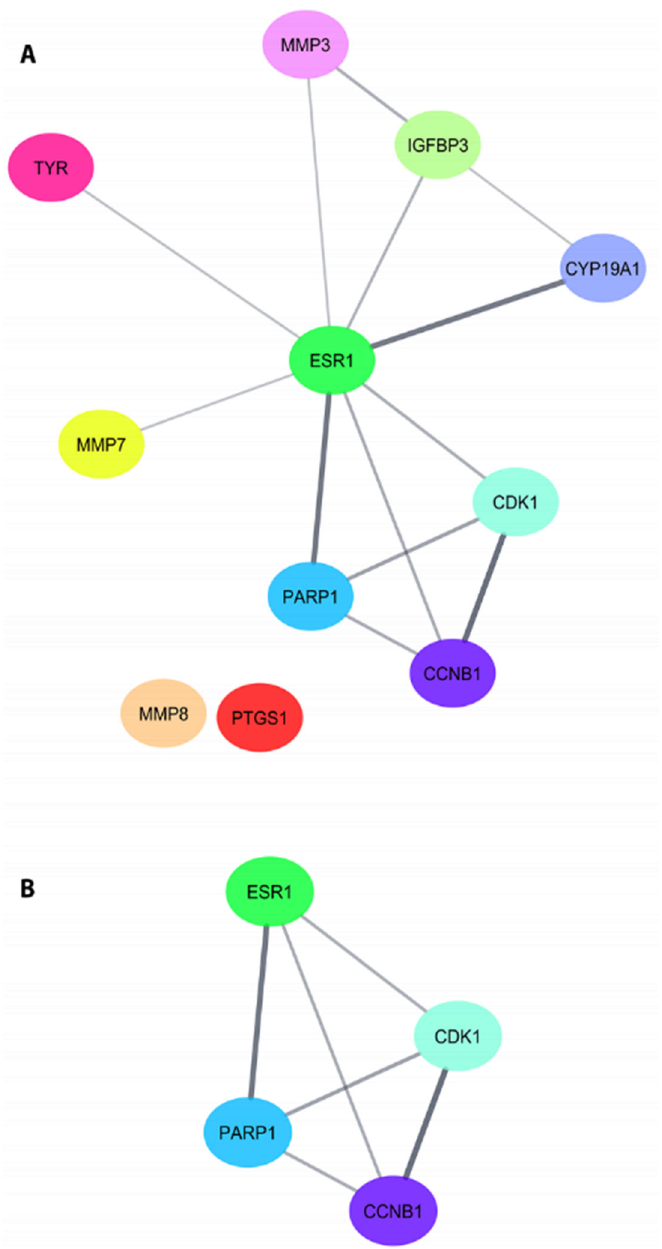
Figure 5. Protein–protein interaction network formed by common proteins between phlorizin, phloretin, TBI ( A ), and MCODE components ( B ), showing ESR1 as the primary cellular hub protein.